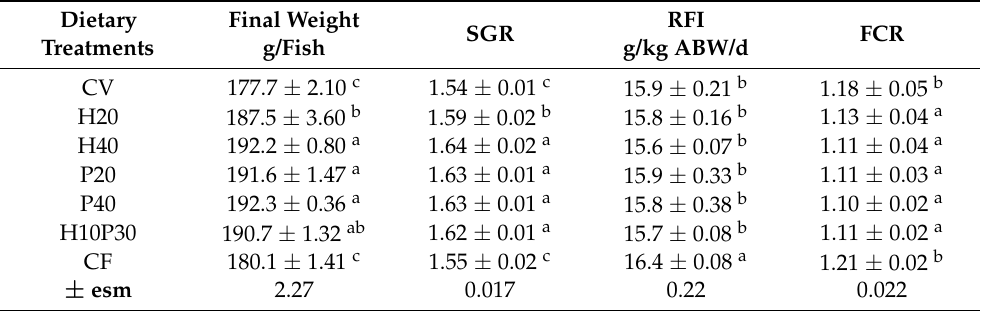
Table 4. Growth performance, specific growth rate (SGR), relative feed intake (RFI), and